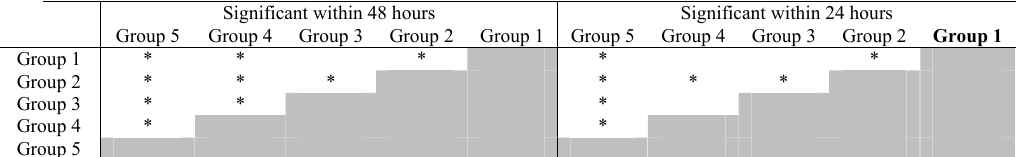
Table 6. Significance at concentration 1.25 at P<0.001 Table 6: Significance at concentration 1.25 at P<0.001